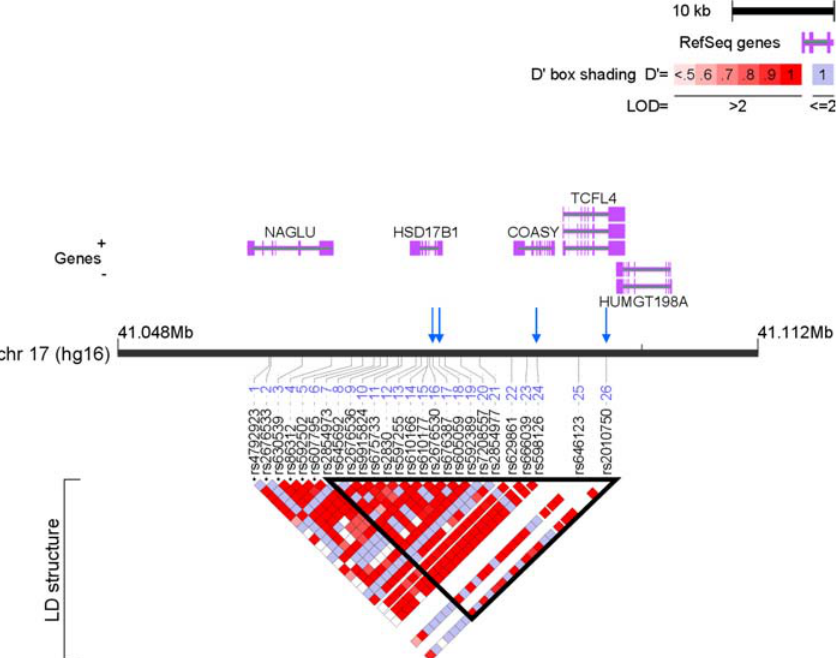
Figure 1. A Scale Map of the 26 SNPs Genotyped in the MEC Screening Panel and a Plot of the Pattern of Linkage Disequilibrium among Them (in Whites) The four tag SNPs are markers with arrows, and the block of high linkage disequilibrium and limited haplotype diversity spanning HSD17B1 is highlighted. DOI: